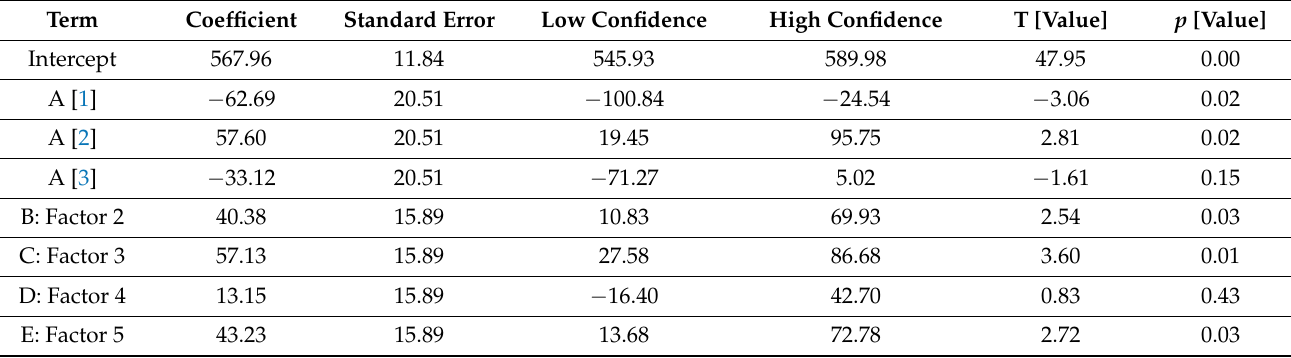
Table 5. Regression Information—Means.